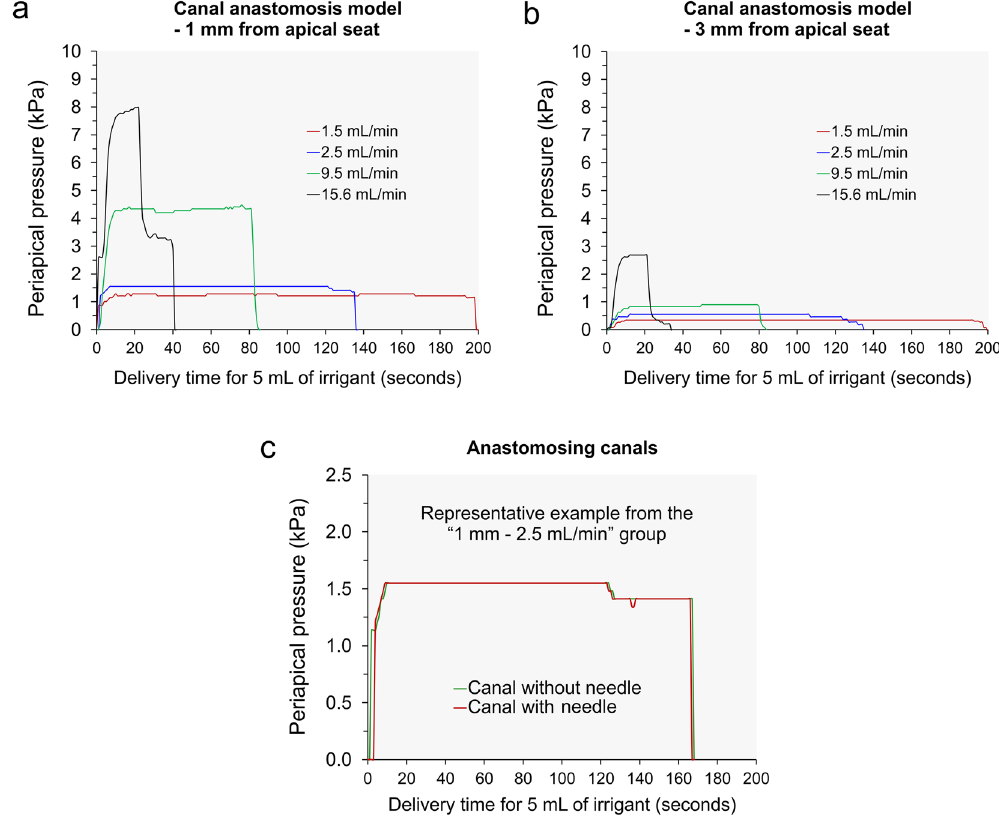
Figure 5. Apical fluid pressures generated in the canal anastomosis model with different fluid flow rates. ( a ) Representative pressure-time plots produced by inserting the side-venting needle to 1 mm above the faux apical terminus in the test canal. ( b ) Representative pressure-time plots produced by inserting the side-venting needle to 3 mm above the faux apical terminus in the test canal. ( c) Representative example of a superimposed pressure-time plot produced in one recording of the test canal and the control connected canal.